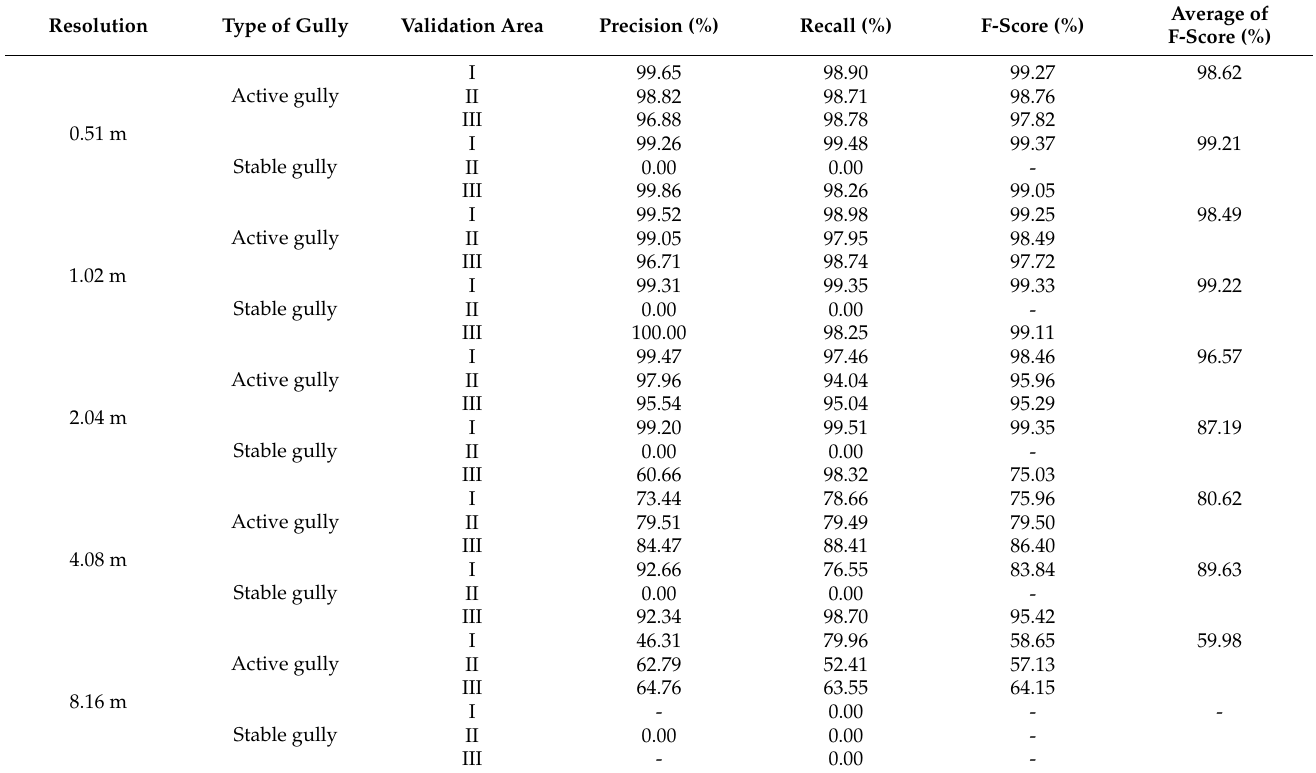
Table 4. Accuracy evaluation of interpretation of active gullies and stable gullies.